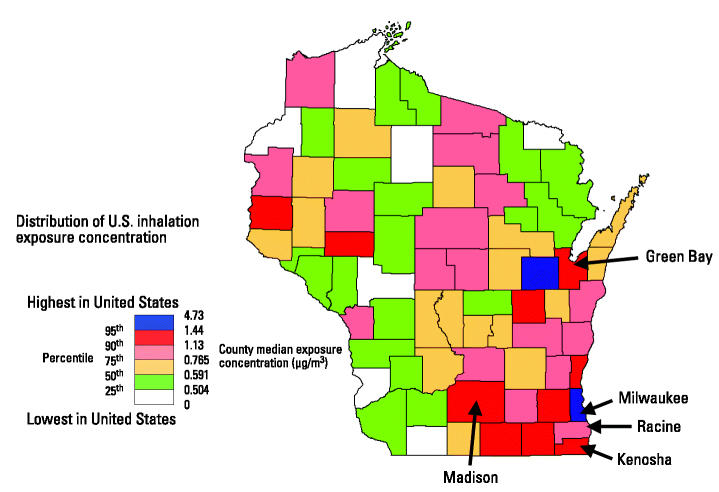
National Air Toxics Assessment: 1996 estimated Wisconsin county median exposure concentration of benzene. From U.S. Environmental Protection Agency/Office of Air Quality Planning and Standards National-Scale Air Toxics Assessment (Technology Transfer Network 2002).